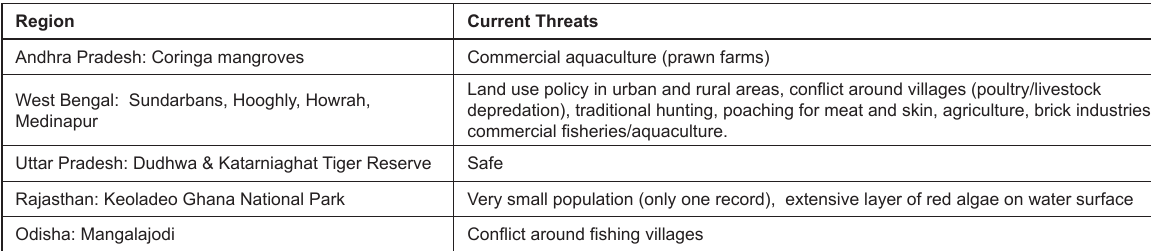
Table 2. Threats to Fishing Cat populations in various parts of their range (2010–2011).